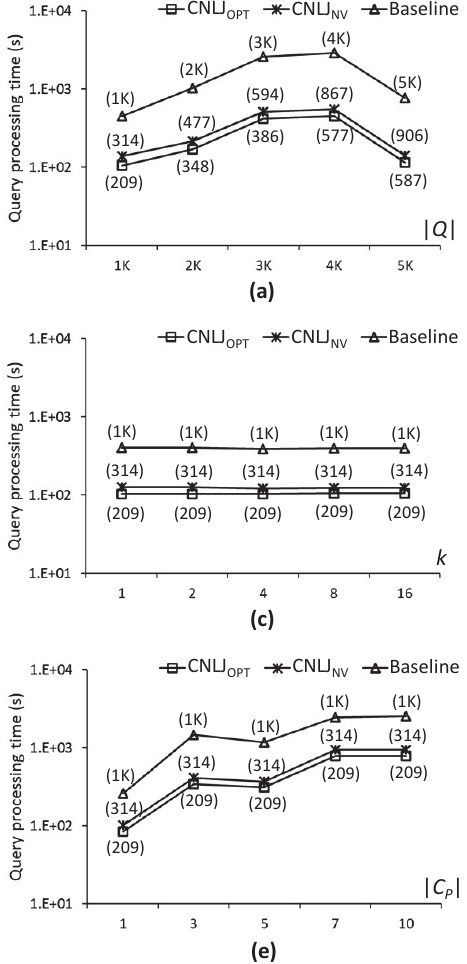
Figure 13. Comparison of k FN join query processing times for the SJ roadmap: ( a ) 10 3 ≤ | Q | ≤ 5 × 10 3 ; ( b ) 10 3 ≤ | P | ≤ 5 × 10 3 ; ( c ) 1 ≤ k ≤ 16; ( d ) 1 ≤